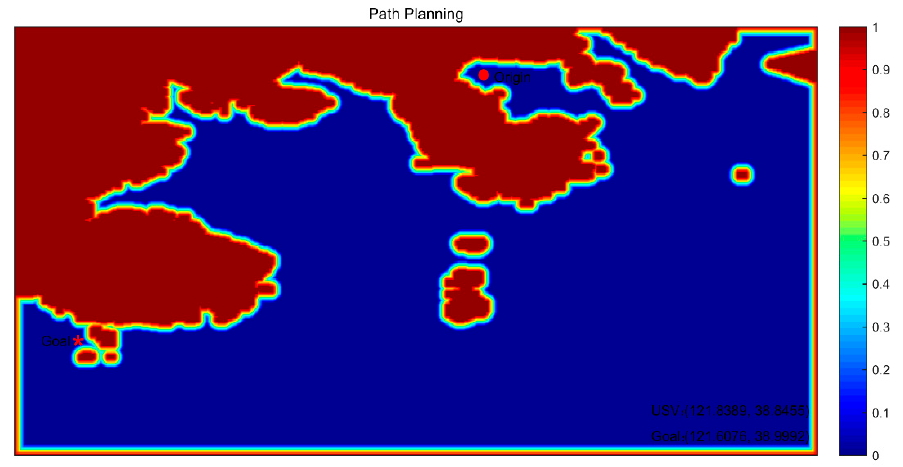
Figure 22. Static global environment.